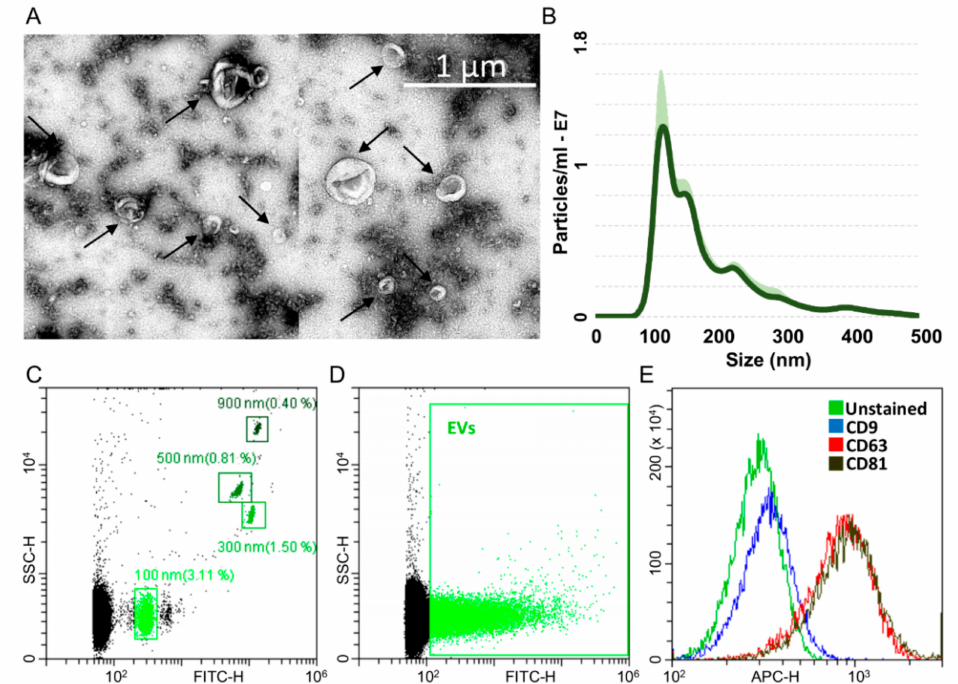
Figure 4. Characterization of ASC-EVs (extracellular vesicles). A ) Transmission electron micrographs of ASC-EVs showing particles with characteristic cup-shaped morphology. B ) Size distribution of nanoparticles by NanoSight particle-tracking analysis. C ) Nanometric fluorescent beads with diameters of 100 nm, 300 nm, 500 nm and 900 nm used for flow cytometer calibration confirmed instrument sensitivity with respect to background. D ) CFSE-stained ASC-EVs (green) with respect to background. E ) Flow cytometry scoring CD63 / 81 EV marker positivity on CFSE-labeled ASC-EVs. CD9 resulted barely positive. One representative donor is